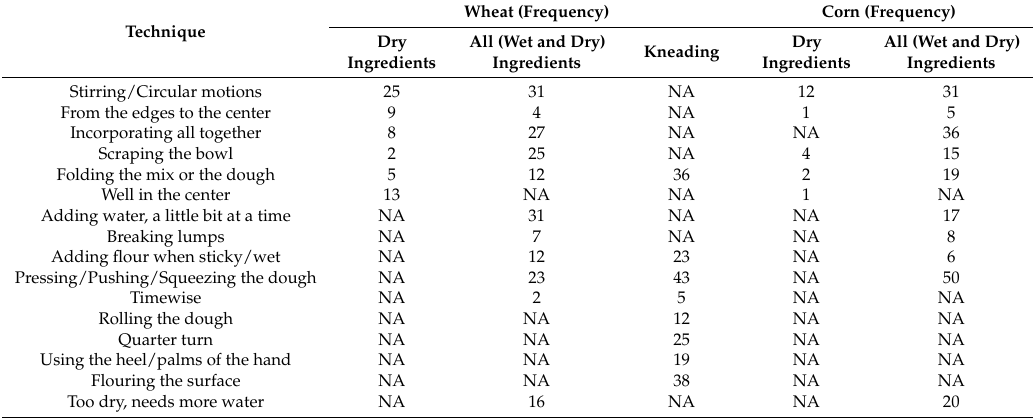
Table 7. Mixing and kneading techniques used by 43 wheat dough preparers and 50 corn dough preparers during the dough preparation